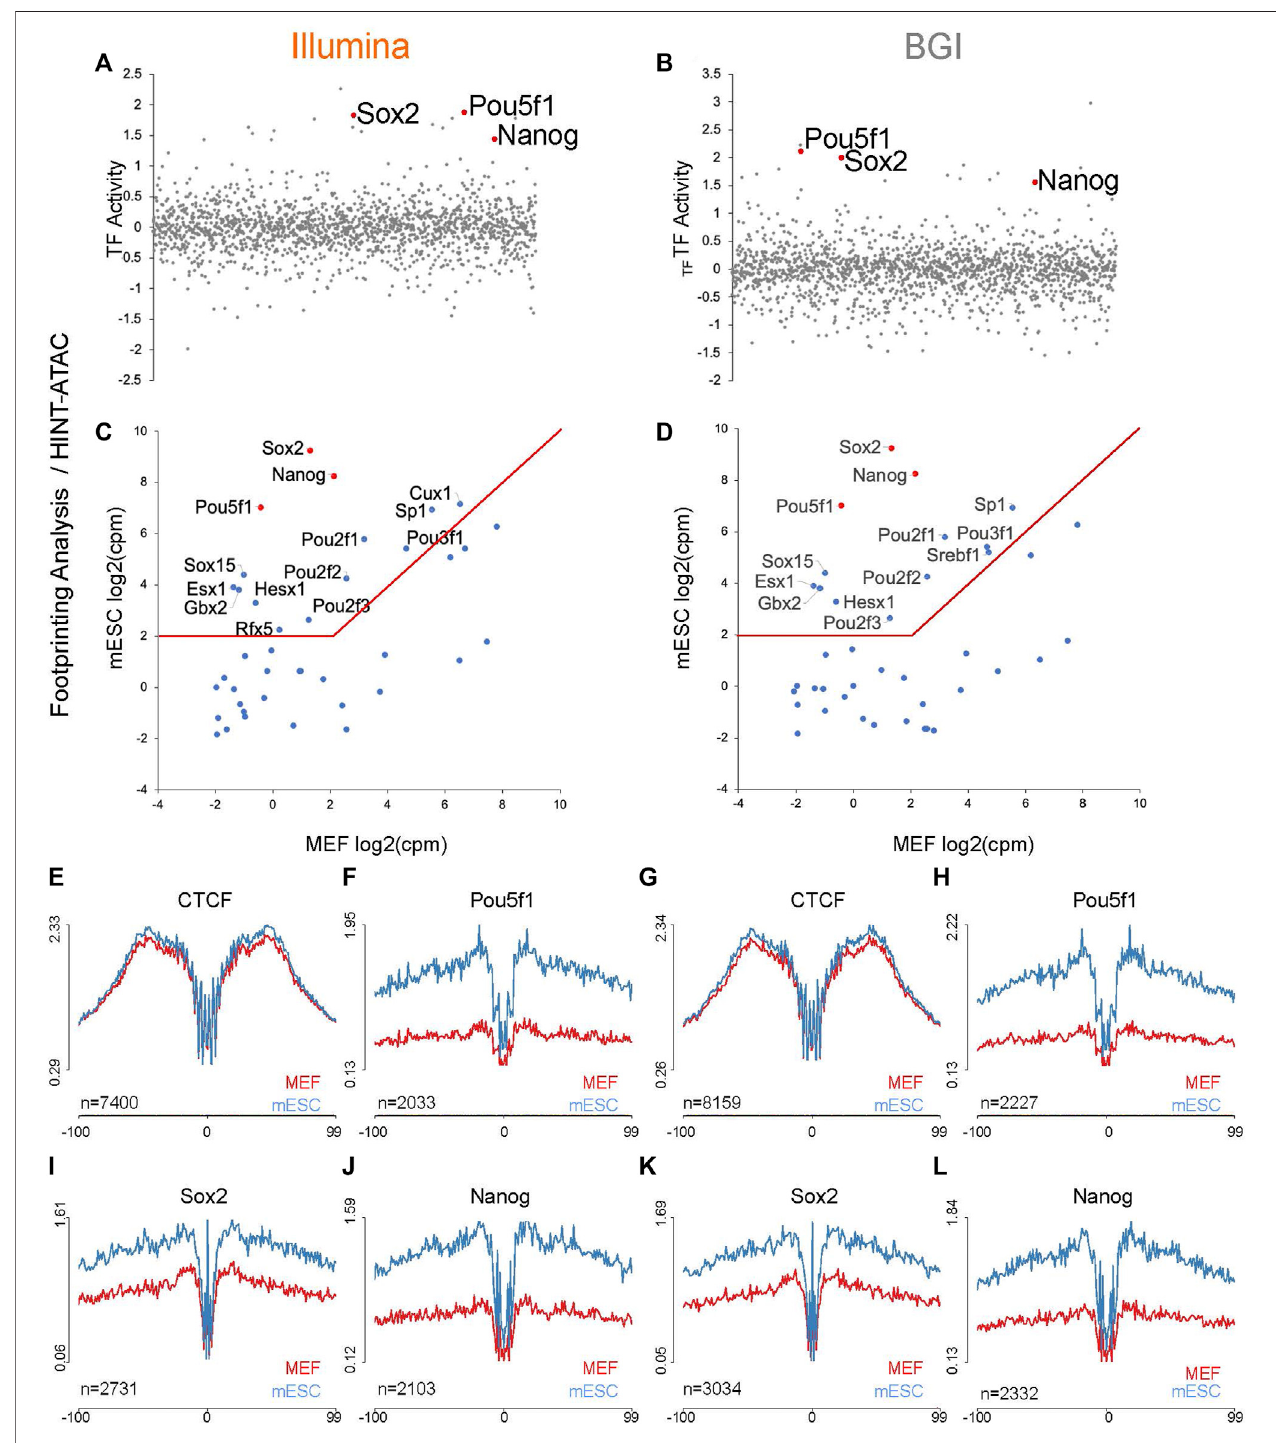
FIGURE 4 | Foot-printing analysis with Hint-ATAC pipeline to recover TF that underpins the mESC identity. (A,B) TF activity changes quanti fi ed by Hint-ATAC pipeline formESCvs.MEFs,positionofPou5f1,Nanog,and Sox2areindicatedinred(analysisisbasedonthemergeddataofthreebiologicalreplicatesasHINT-ATAC does not accept replicate data). (C,D) The top 40 motifs identi fi ed by Hint-ATAC with higher activity in mESC were integrated with transcriptional data for mESCs and MEFs( n = 3biological replicates) tovisualizeexpression differences oflinked TFs across both celltypes. Thetop threemotifs(re-ranked by expression differences) are indicated in red. (E – L) Representative aggregate accessibility pro fi les of TFBS with evidence for occupancy in the cell types for CTCF, Pou5f1, Sox2, and Nanog (pro fi lesarebased onthemerged dataofthree biologicalreplicates).ThenumberofTFBSusedtogenerate eachaggregateisindicatedinthebottom leftcorner ofeach plot and is based on PMW scanned sites (with evidence for occupancy in one of the cell types) that intersect with a sample ’ s open chromatin regions.